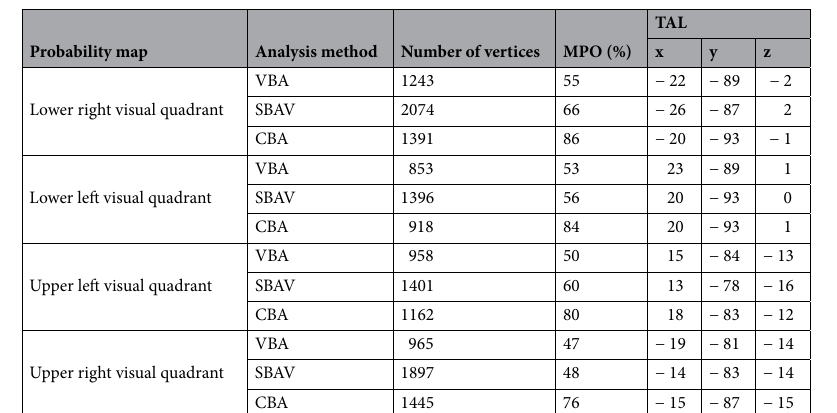
Upper right visual